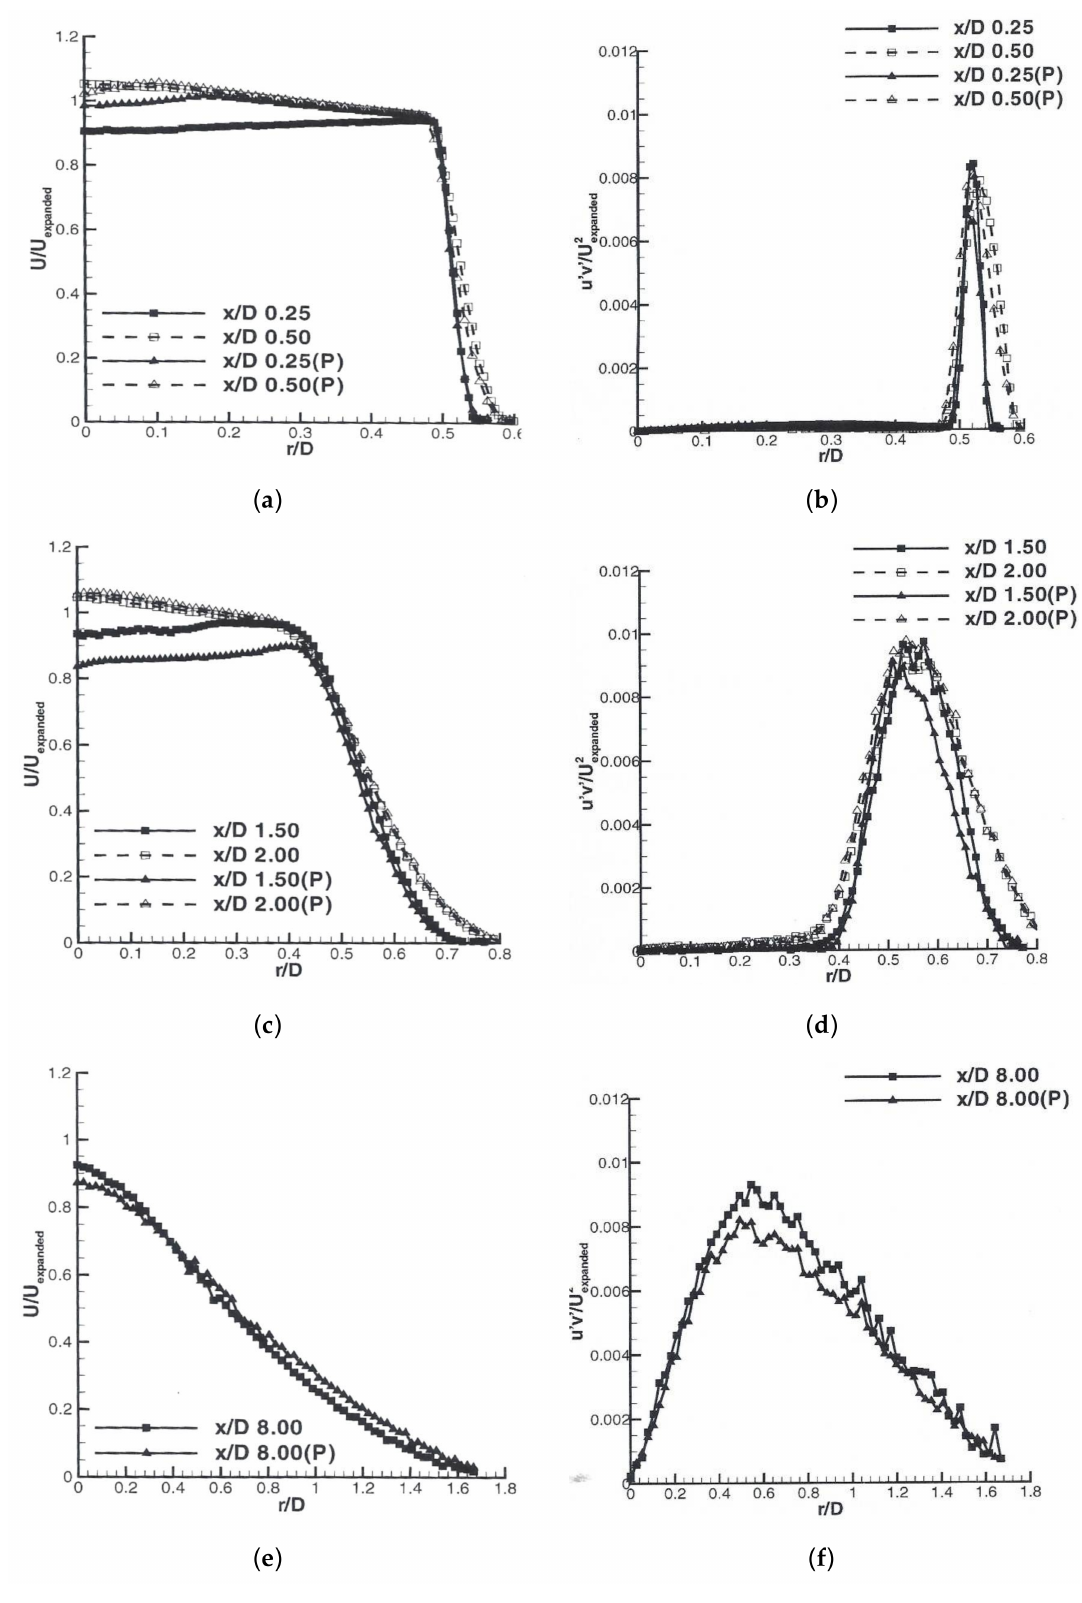
Figure 21. Radial profiles: mean velocity (left), Reynolds shear stress (right), LU48/LU48P, NPR = 2.4. ( a , b ) x / D = 0.25 and 0.5; ( c , d ) x / D = 1.5 and 2.0; ( e , f ) x / D =